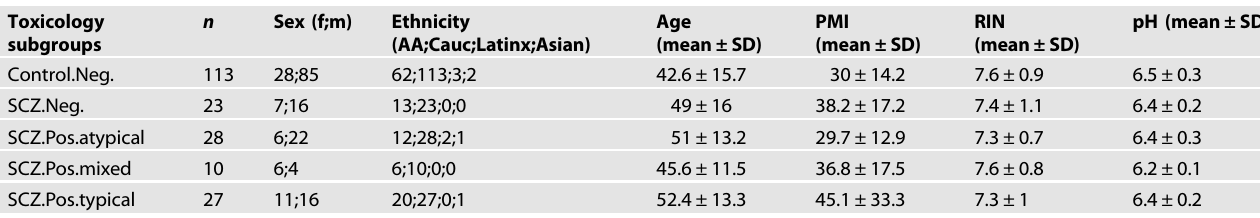
Table 1. Overview of the human